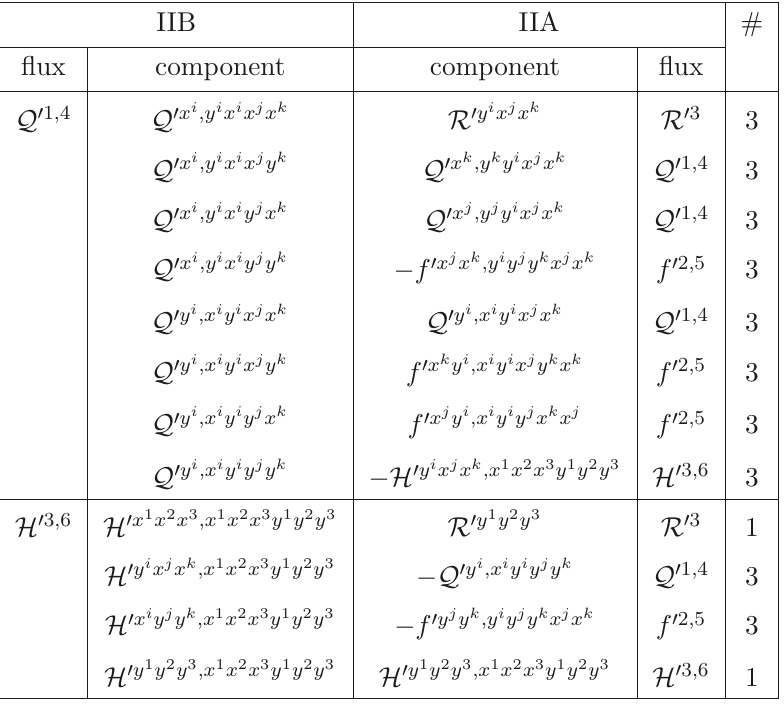
Table 2 . Table containing all the NS ′ fluxes that can be turned on in the N = 1 orientifold model for both IIB and IIA. In the last column we give the number of independent components for each flux, whose total number is 32.